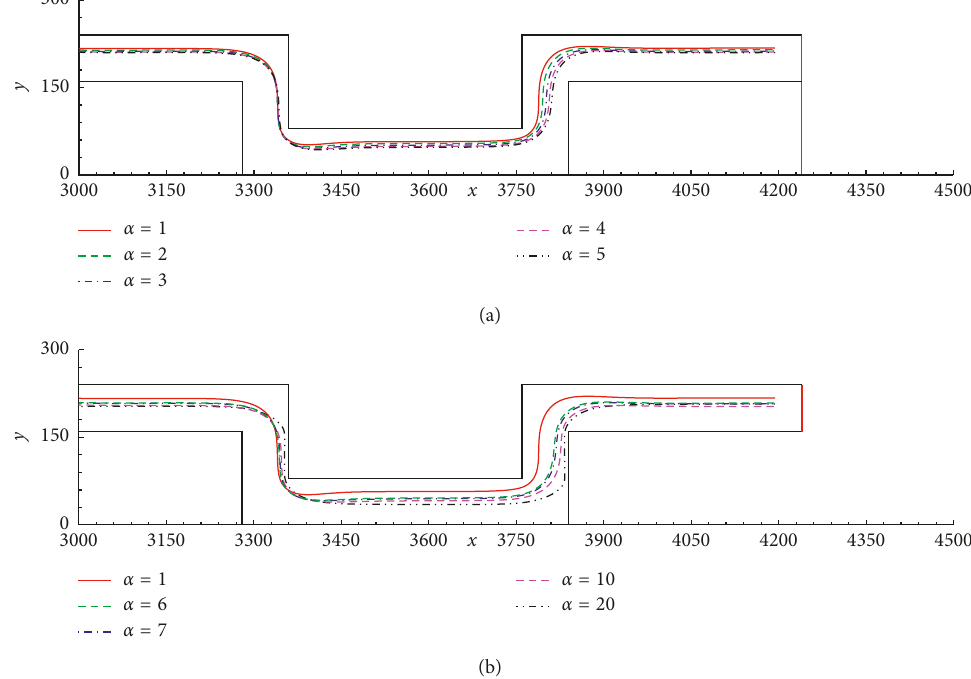
Figure 10: Particle trajectories for different density ratios when α